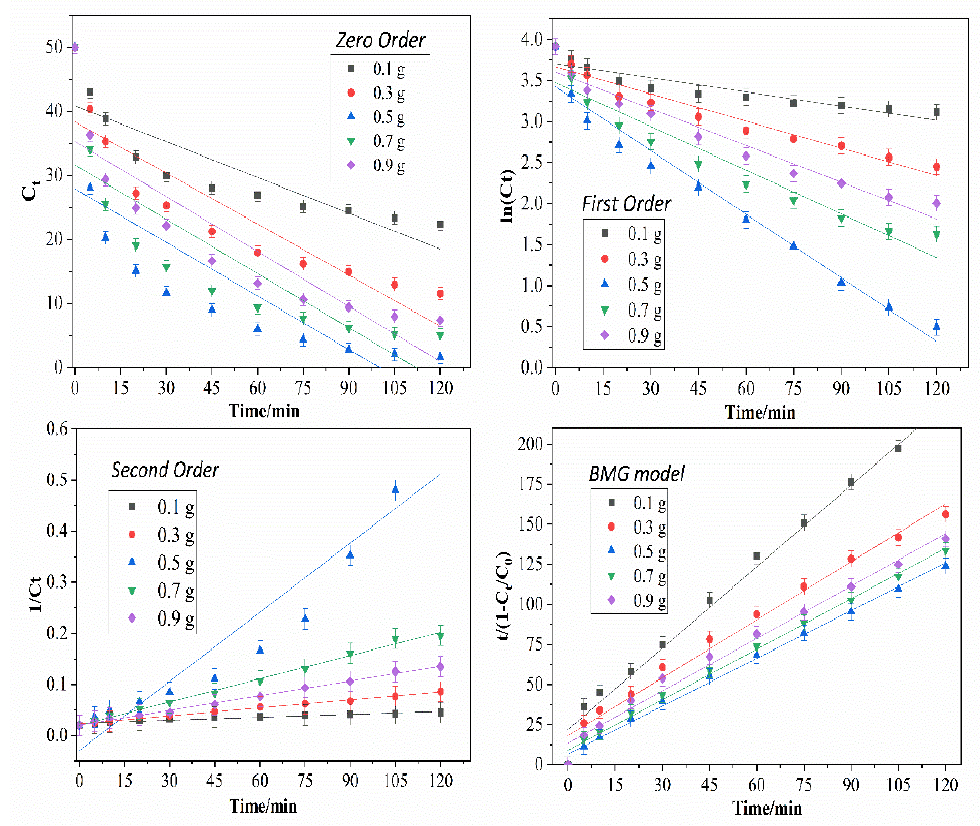
Figure 10. Degradation data of glyphosate using different kinetic models under different initial CaO 2 dosages.